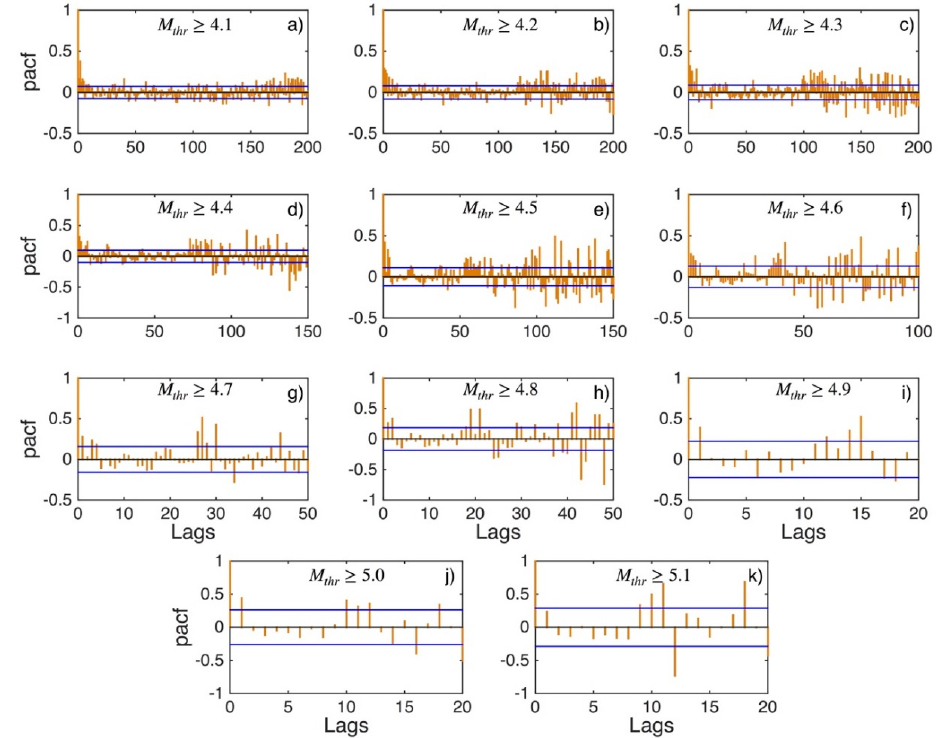
Figure A2. PACF values (orange stems) and their 95% confidence intervals (blue lines) for Western Greece and Albania (sub-area 1) for magnitude thresholds ( M thr ) varying from 4.1 to 5.1 (subplots a – k ).